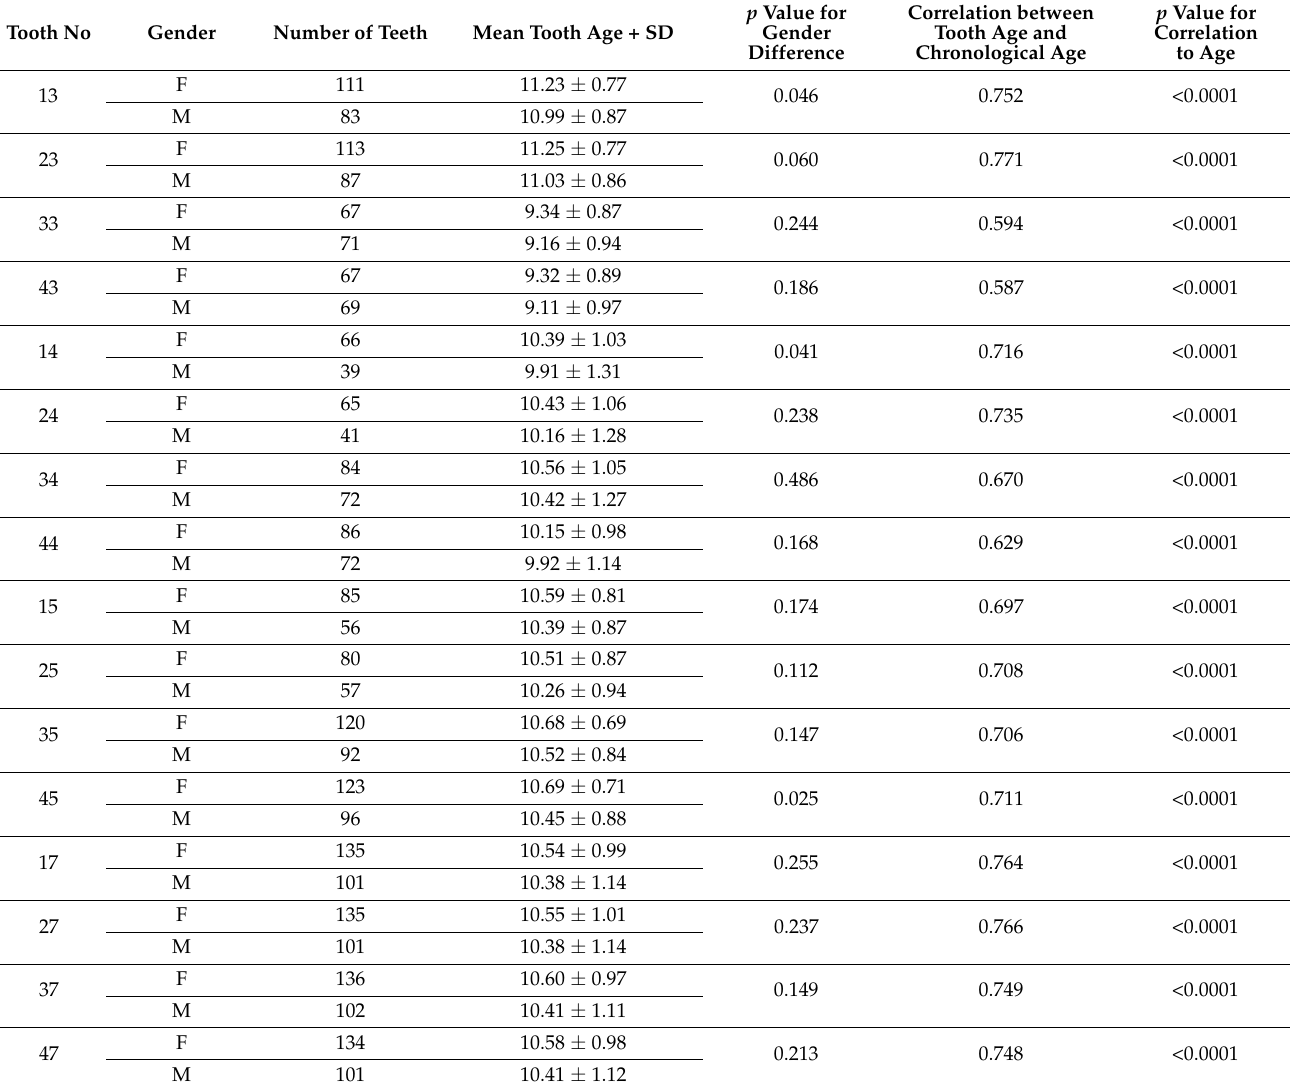
Table 2. Statistics for examined teeth.